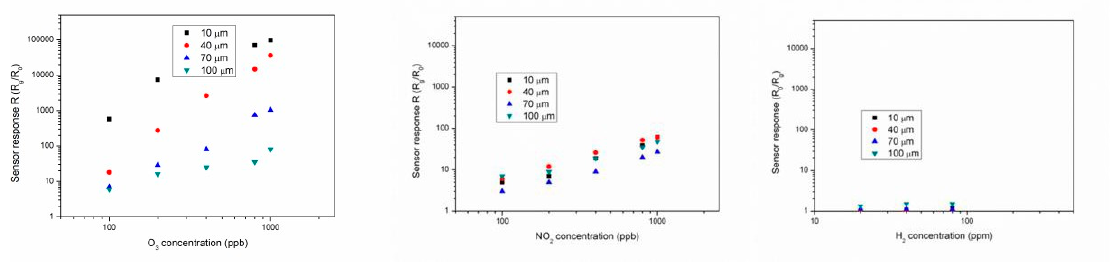
Figure 1. Comparison between 10, 40, 70 and 100 µm thick In 2 O 3 sensor response towards O 3 ( left ), NO 2 ( center ) and H 2 ( right ) at 150 °C and 30%